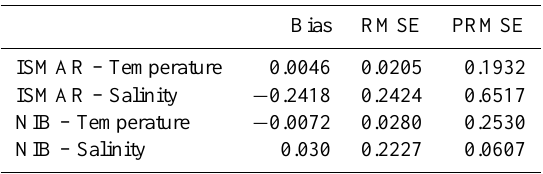
Table 2. Bias, root mean square error (RMSE) and percent RMSE computed for the ISMAR and NIB MSS probes compared to CTD